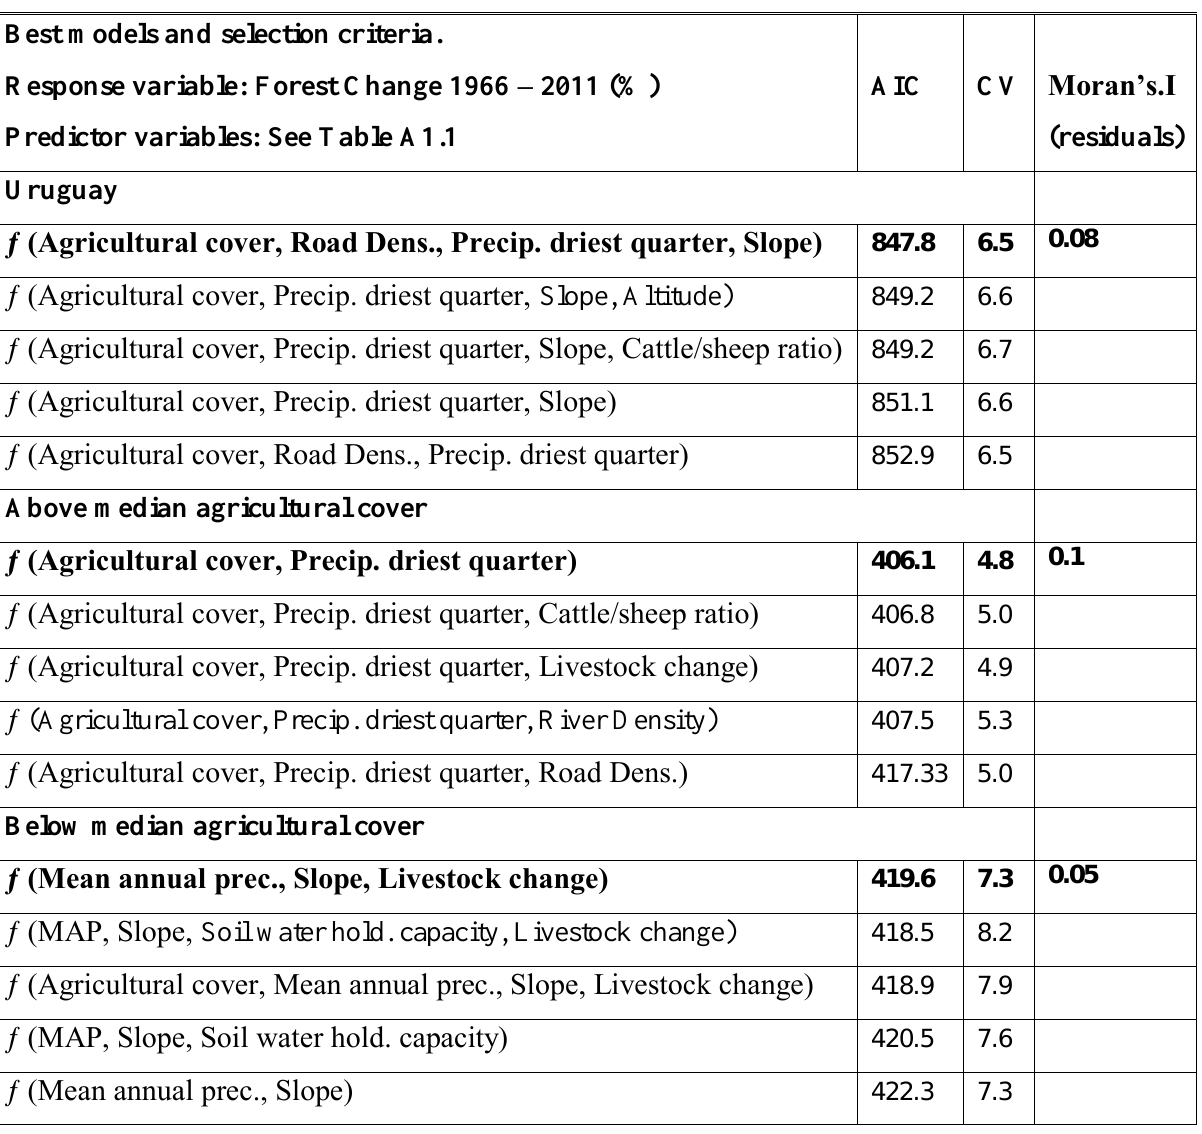
Table A1.2, Best models and selection criteria. Best models obtained with the function Bestglm in R (McLeod and Xu 2011). Model selection was done by AIC and tested by Cross Validation. Best alternative models (not retained by the selection criteria) are shown. Moran’s I values were calculated to assess spatial autocorrelation.